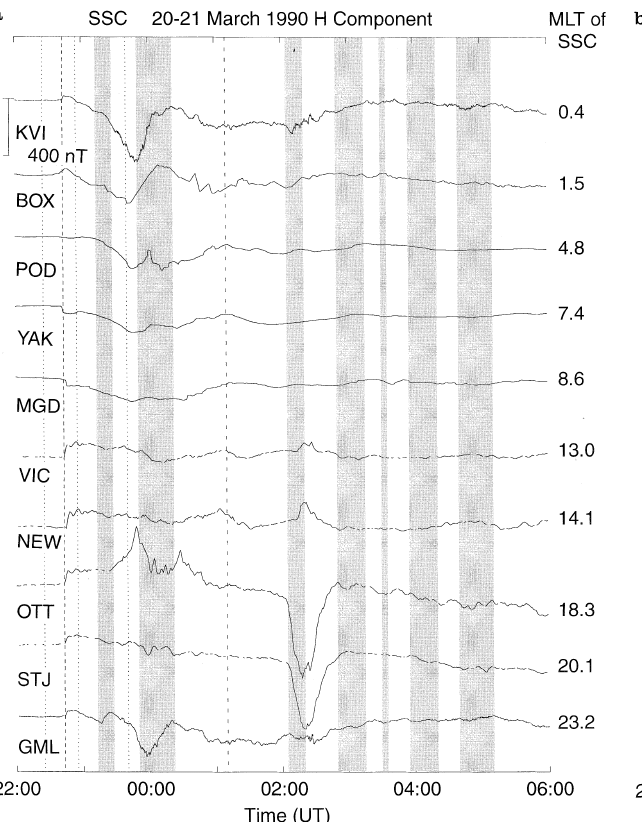
Fig. 5.a,b Ground magnetometer plots of sub-auroral stations (at (cid:24) 55 (cid:176) N) for interval 1, 2200 UT March 20 to 0700 UT March 21 presenting the SSC at 2243 UT (- - - - -) for the H component. Substorm expansion phase onsets identified from Pi2 waves from CANOPUS, SAMNET and EISCAT Magnetometer Cross data and additional expansion phase onsets identified from bays in data from Russian and